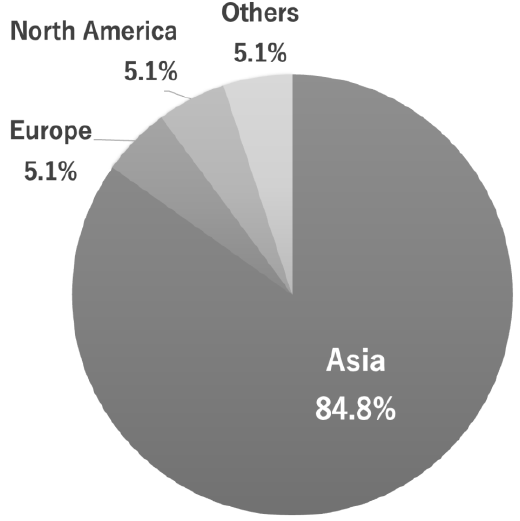
Figure 1. Region of origin of international university students in Japan. Note: Of the 231 university students under the age of 25, 79 were international students. Of these, 84.8% ( n = 67) were from Asian countries, the highest percentage, followed by 5.1% ( n = 4) from both North America and Europe.